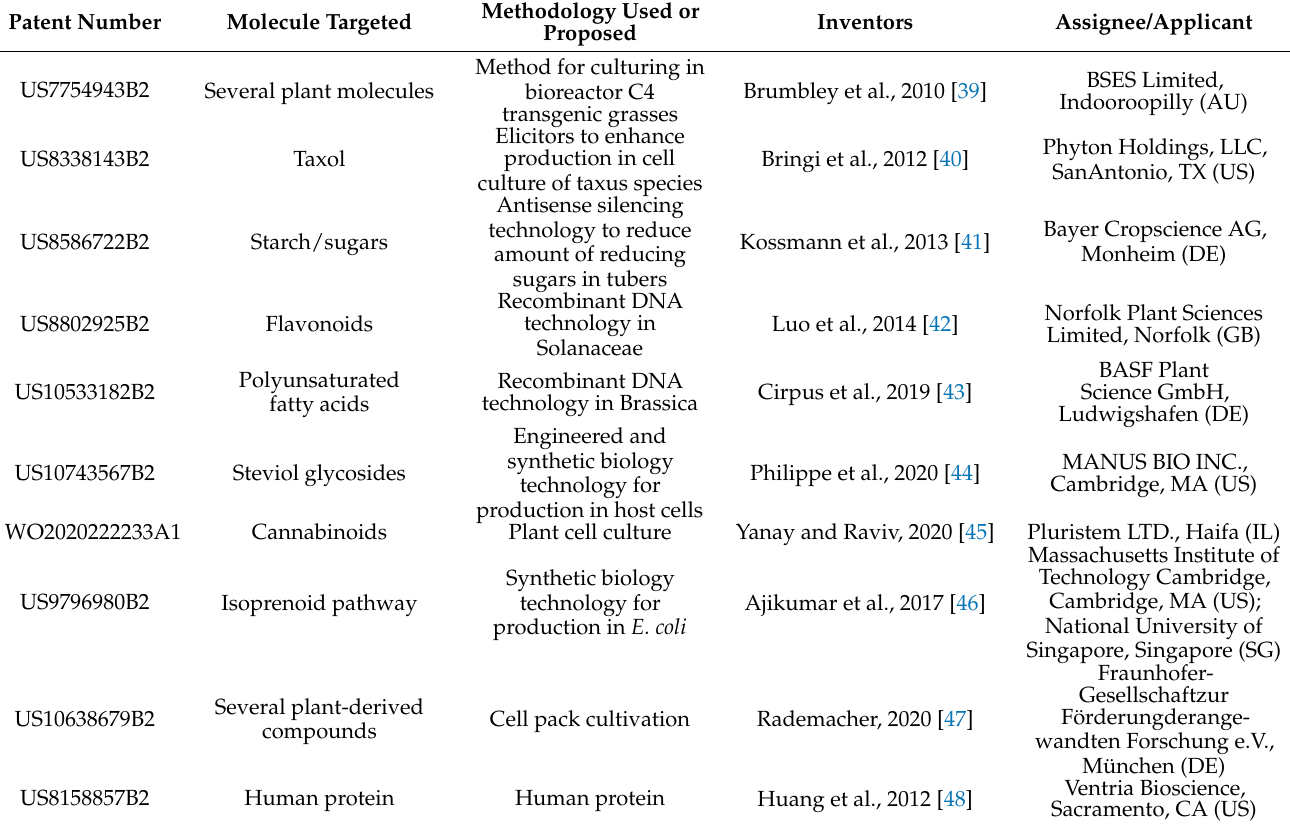
Table 1. Examples of published patents that use plants for the production of